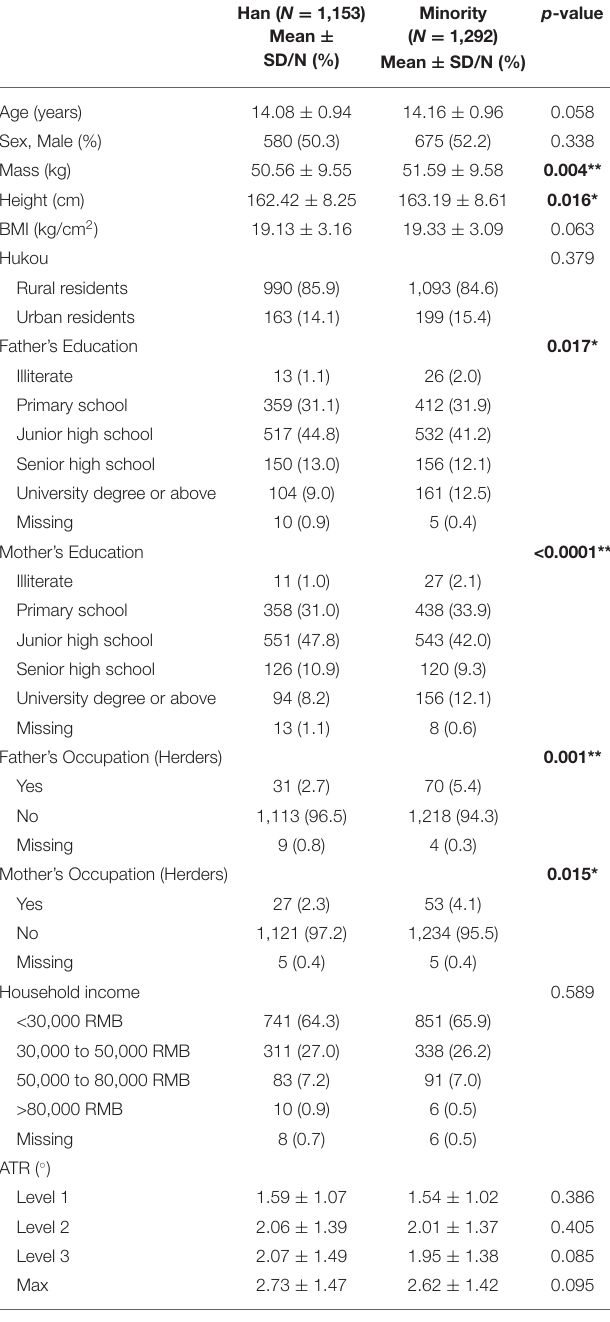
TABLE 1 | Demographics and SES of families included in the